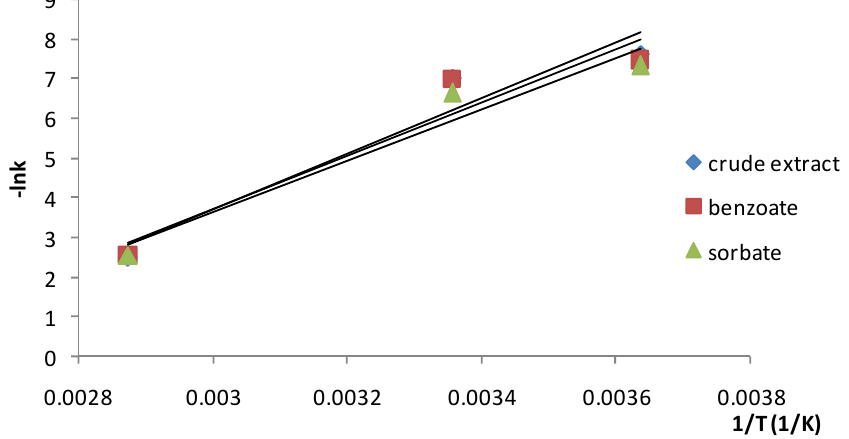
Figure 4. The Arrhenius plots for degradation of anthocyanins in Cornelian cherries